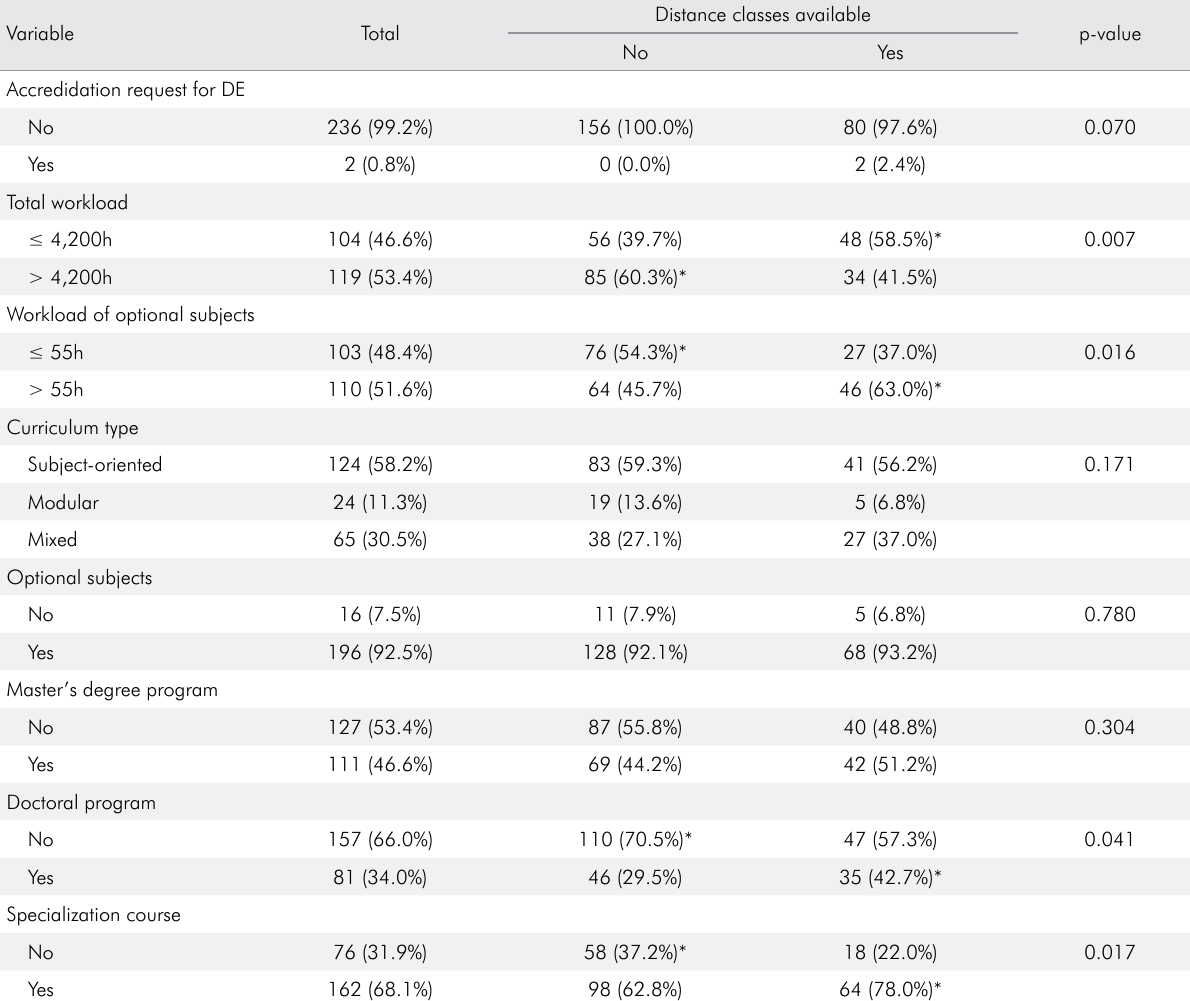
Distance classes